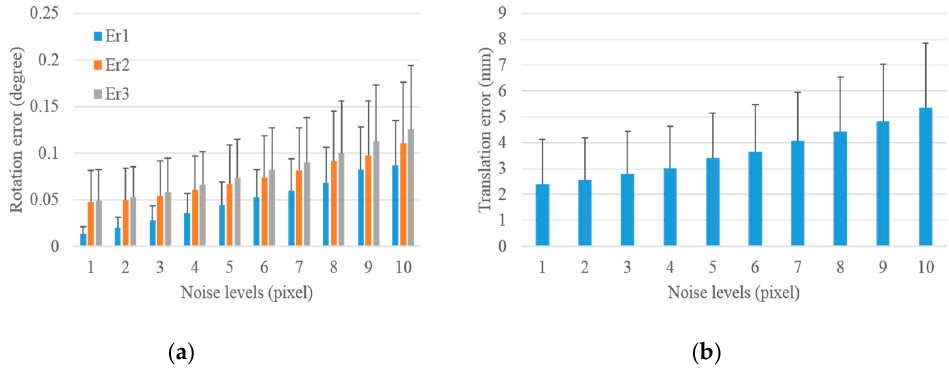
Figure 7. Rotation and translation errors for the extrinsic calibration of LRF with respect to the camera under increasing image noise levels. ( a ) Rotation error and ( b ) translation error.